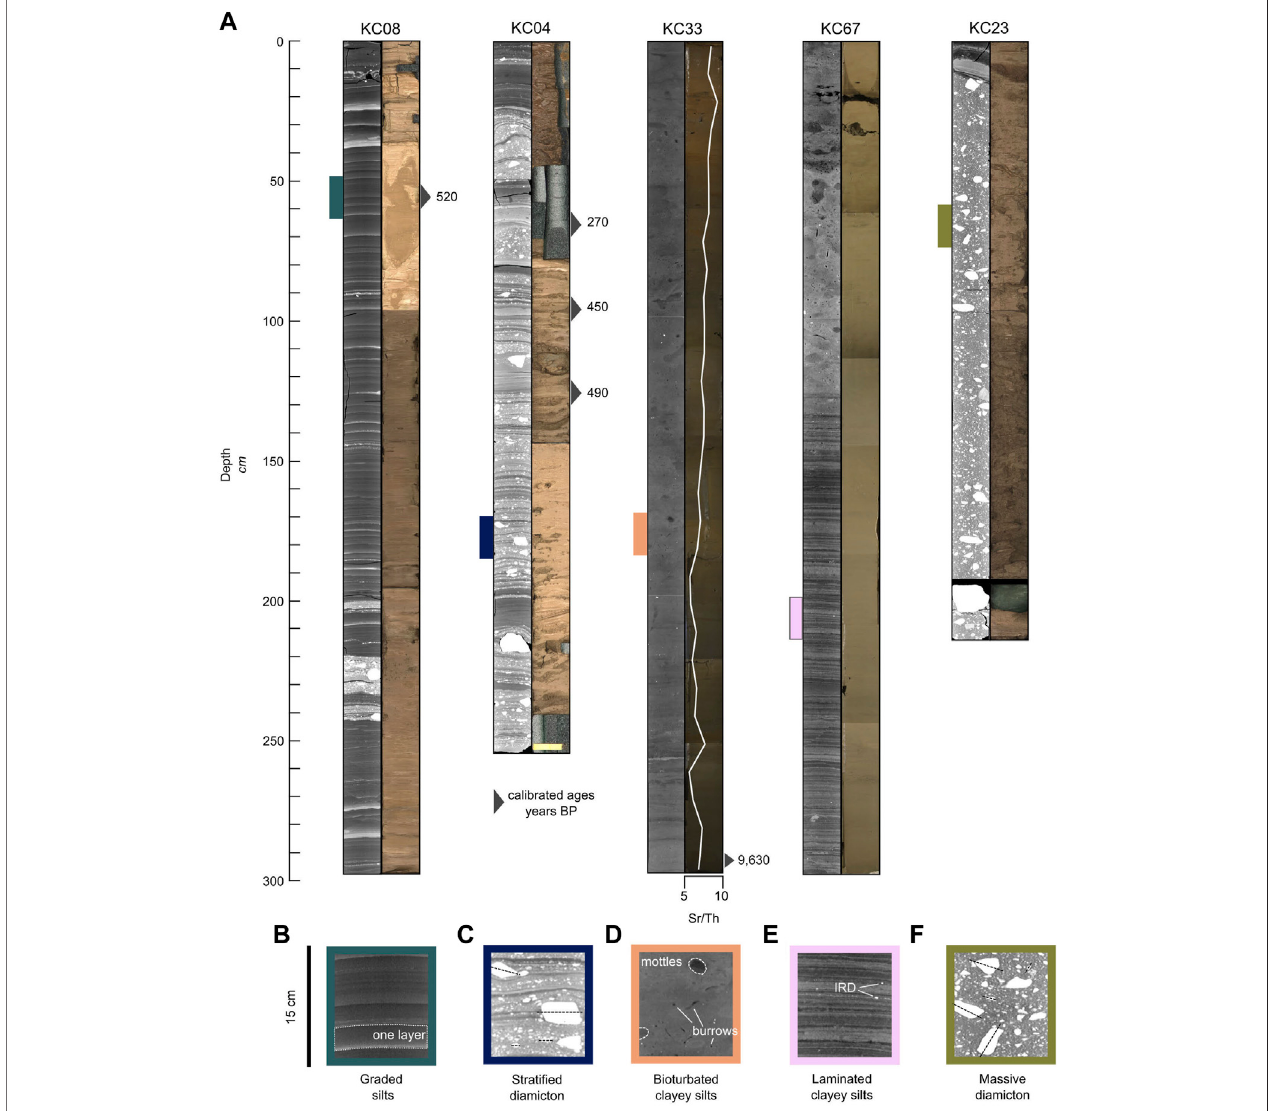
FIGURE6 | Greyscale computed tomography (CT) images ofsediment cores collected offshore Thwaites Glacier. (A) CT image nextto linescan photo. Downcore Sr/ThisimposedoncoreKC33andre fl ectsagradualchangeinsedimentsource. Dates(calyrBP)areshownalongsidethecorrespondinginterval.Referto Table2 for errorbounds.Coloredverticallinesdenotecoresectionsshownin (B – F) . (B – F) Sedimentfaciesdescribedinthisstudywithannotations.Long-axisorientationforclasts of varying sizes is traced in diamicton facies (C, F) . Note that more than one sediment facies is observed within each